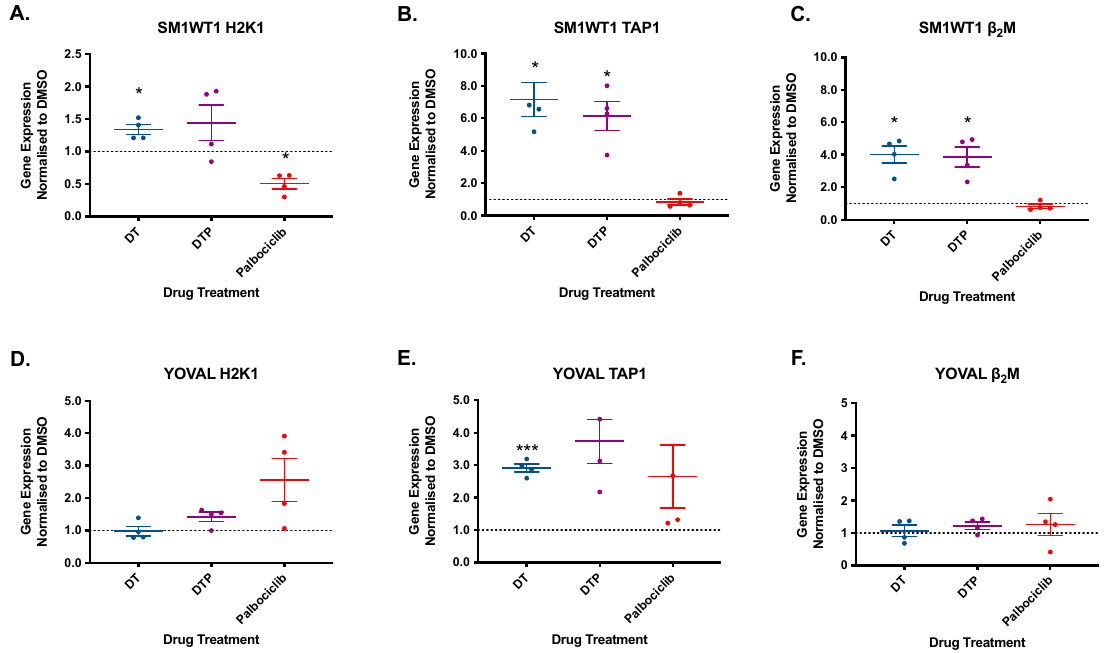
Figure 6. SM1WT1 and YOVAL1.1 gene expression of H2K1, TAP1 and β 2 M. SM1WT1 and YOVAL1.1 treated with control (DMSO), dabrafenib-trametinib (DT), dabrafenib-trametinib-palbociclib (DTP), and palbociclib monotherapy. Samples analyzed using real time PCR for H2K1 ( A , D ), TAP1 ( B , E ), and β 2 M ( C , F ). Mean ± SEM, n = 4. Gene expression normalized to DMSO control. Statistical significance was determined using one way ANOVA * p < 0.05, *** p < 0.001